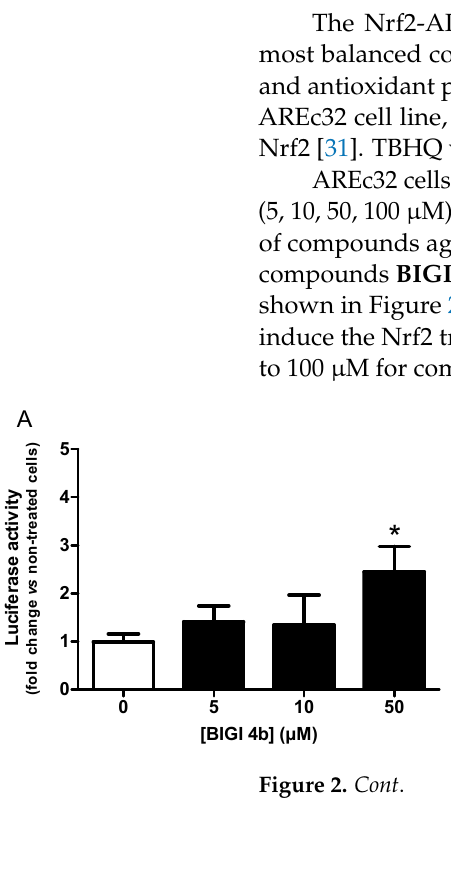
a Every percentage value is the mean of a triple of at least two different experiments. b Data are expressed as Trolox equivalents and are the mean ( n = 3) ± SEM. nd: not determined. The Nrf2-ARE-activating effect of BIGI 4b, BIGI 4d, BIGI 5b , and BIGI 5d , the most tioxidant power, was determined in vitro using a cell-based luciferase assay in the AREc32 cell line, which represents a good model for the redox-dependent activation of Nrf2[31]. TBHQ was used as the positive control.